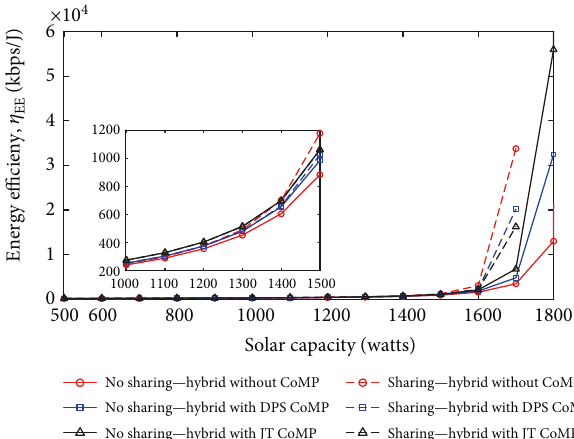
Figure 12: EE of the di ff erent hybrid schemes with energy sharing under equal solar capacity.